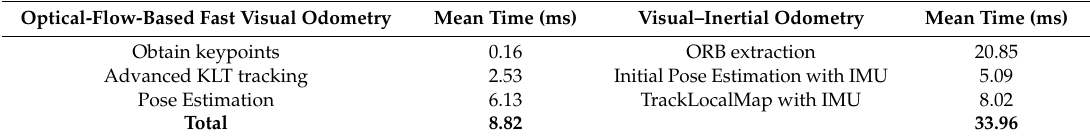
Table 6. Comparison of the average execution time between optical-flow-based fast VO method and VIO method.